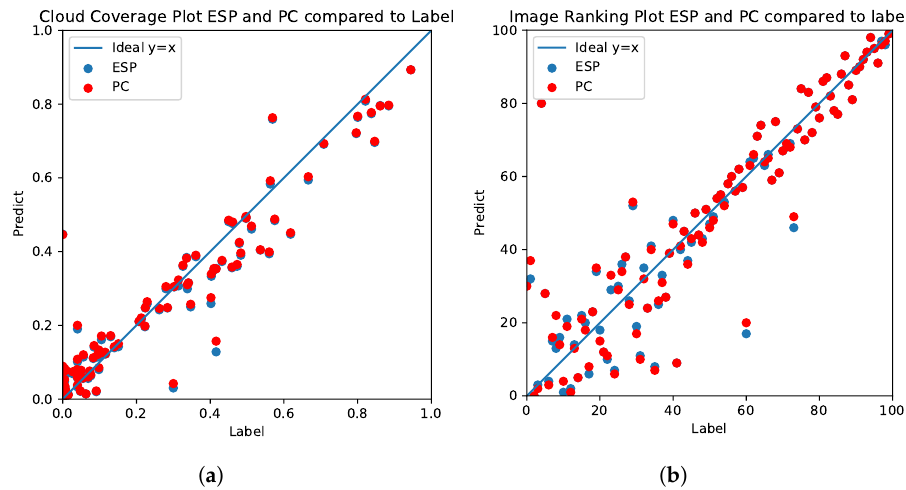
Figure 9. Comparison of predicted output by NU-Net-mod on PC vs. embedded device. ( a ) Cloud coverage; ( b ) Rank.